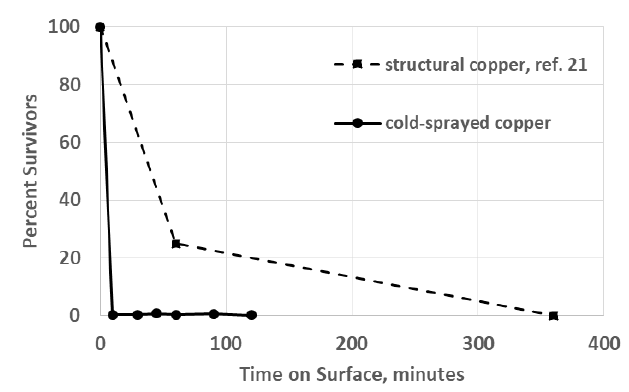
Figure 5. Percent of influenza A survivors as a function of exposure time to copper surfaces.